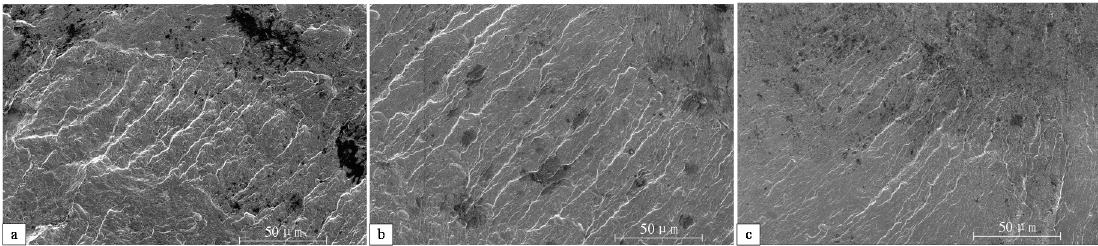
Figure 9. Fatigue strips of the fractures. ( a ) Group 1; ( b ) Group 2; ( c ) Group